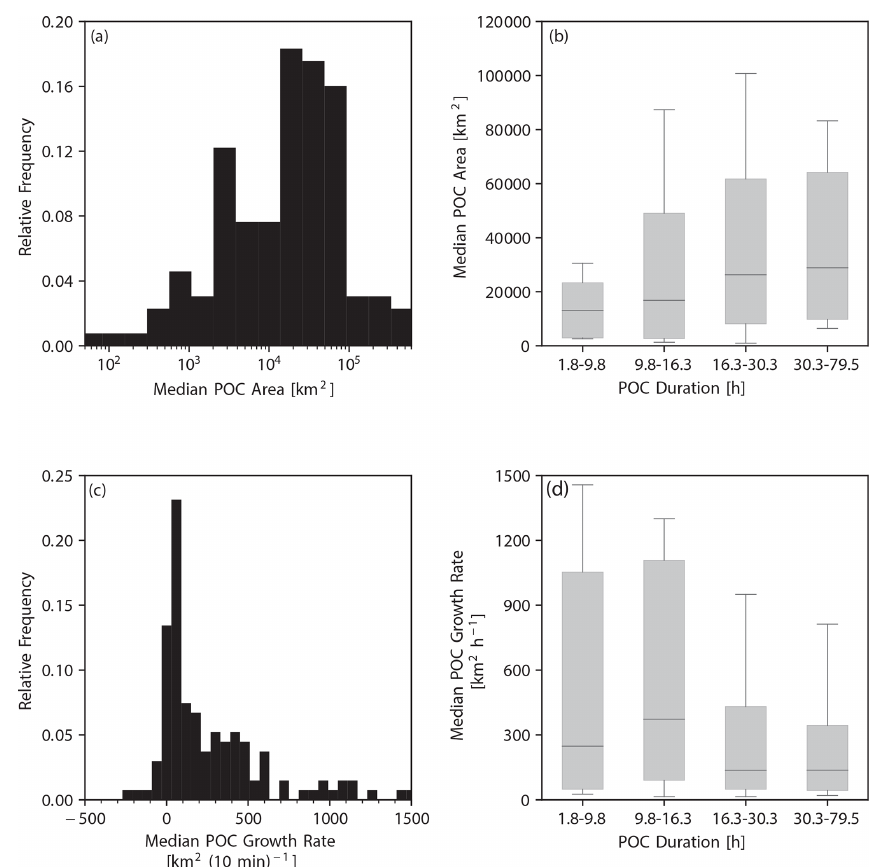
Figure 8. The histogram of the median area of pockets of open-cell stratocumulus (POCs) is shown in panel (a) , the distribution of median POC area as a function of POC duration is shown as box plots in panel (b) , where the solid line represents the median duration, the histogram of POC median growth rate is shown in panel (c) , and the distribution of median POC growth rate as a function of POC duration is shown as box plots in panel (d) . Note that in the boxplots, the shaded boxes represent the interquartile range, the solid lines inside the shaded regions represent the median, and the whiskers represent data between the 10th and 90th percentiles.